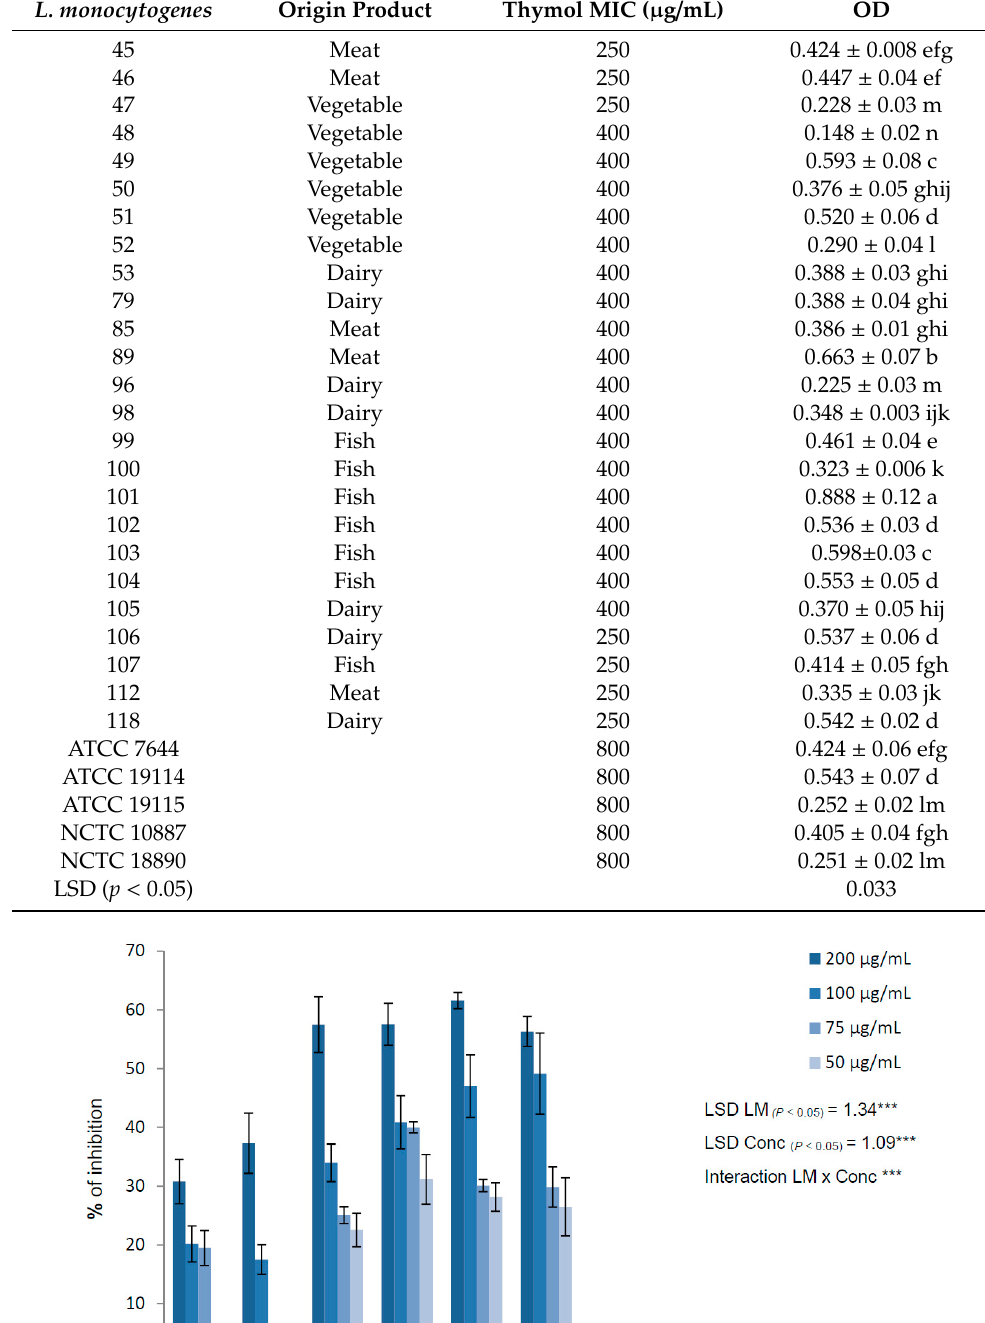
Table 3. Evaluation of biofilm formation as the optical density (OD) of crystal violet-stained adherent biomass and thymol MIC values in µ g / mL against L. monocytogenes isolates and reference strains. The averages from three independent experiments are reported with the SD values. Di ff erent letters indicate statistical di ff erences at p < 0.05 among the L. monocytogenes isolates. L. monocytogenes